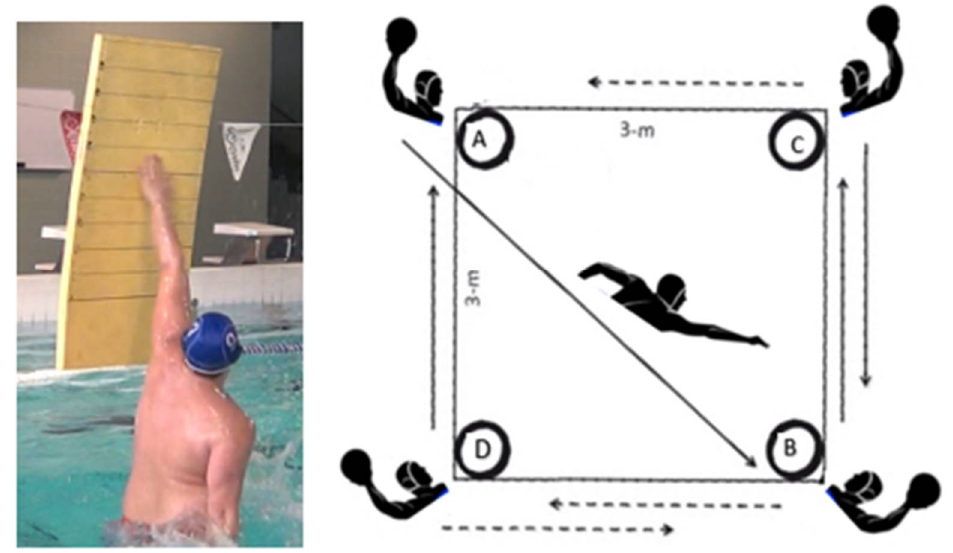
Figure 1. In-water vertical jump and agility tests ( left and right panels, respectively).